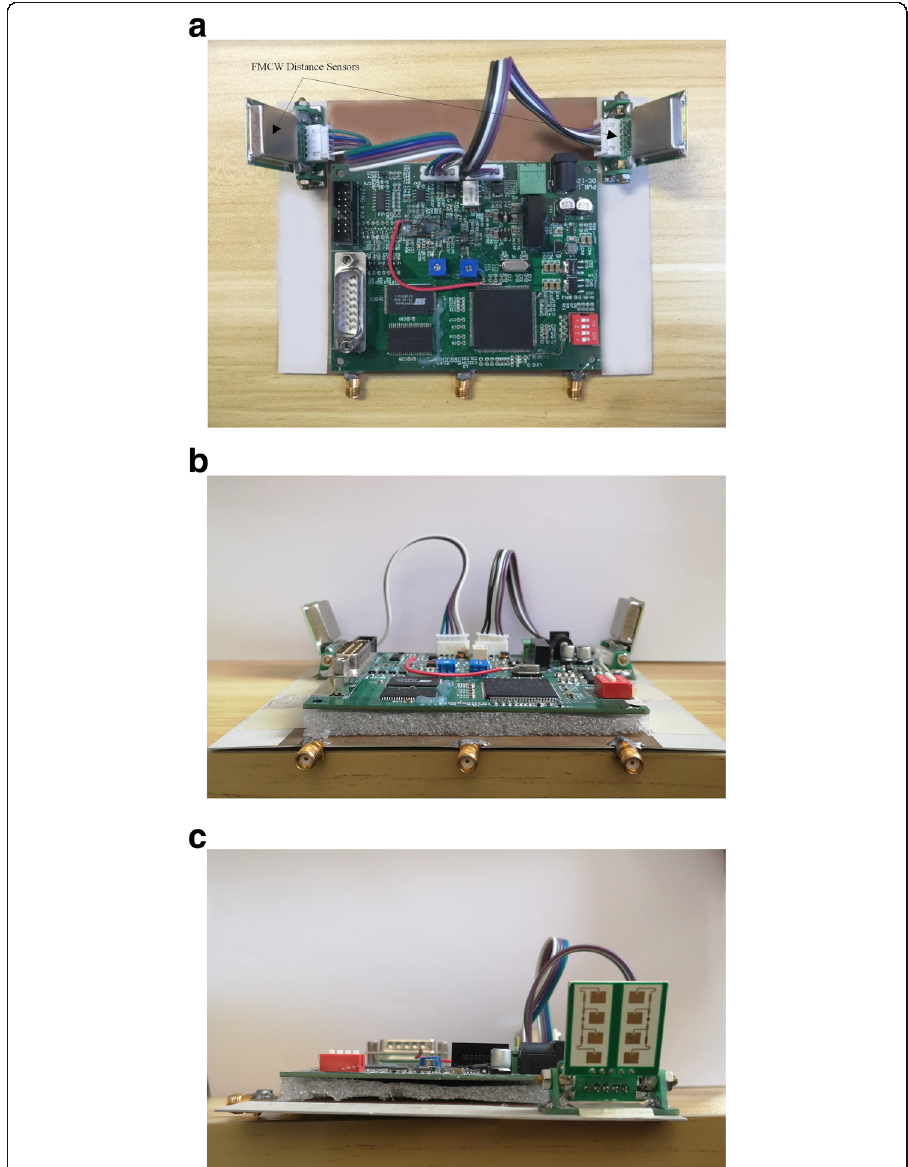
Fig. 7 Prototype of the smart antenna. a Top view. b Front view. c Side